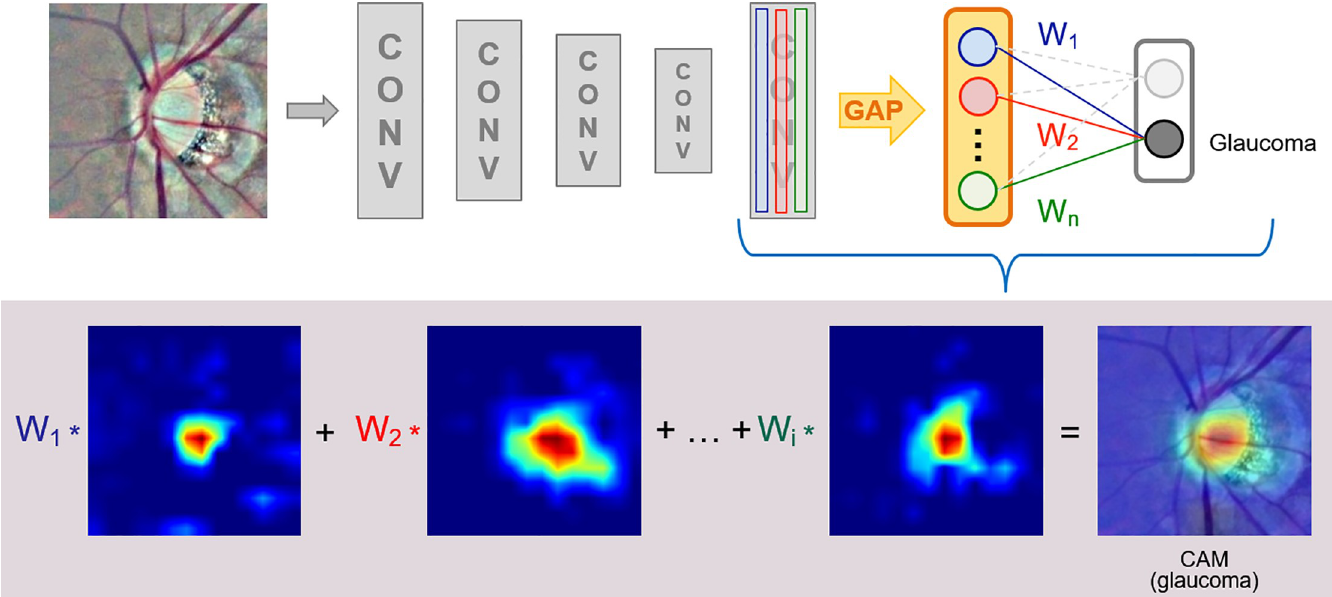
Fig 4. Class activation map attached to the final layer of the proposed CNN model. CAM revealed the important areas for the final classification and was generated using GAP with the multiplication of each channel by the given weight from the fully connected (fc) layer (W1, W2 ... Wn). CAM, class activation map; CNN, convolutional neural network; CONV, convolutional; GAP, global average pooling.